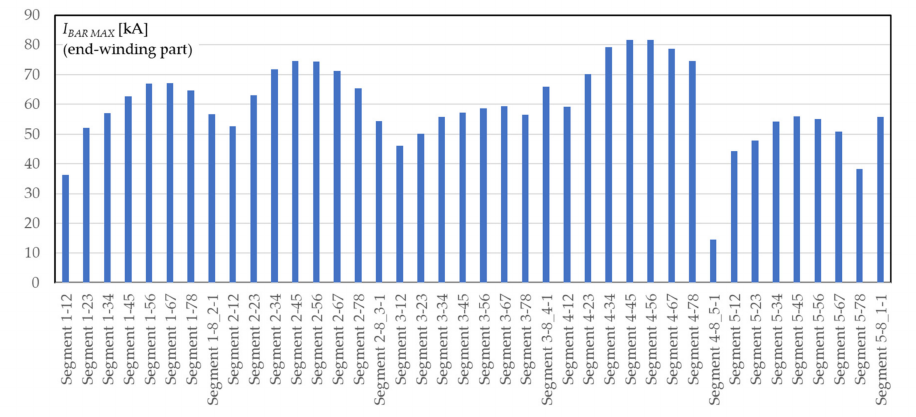
Figure 26. Distribution of maximum values of currents induced in the active part of the rotor bar during the sudden short circuit.